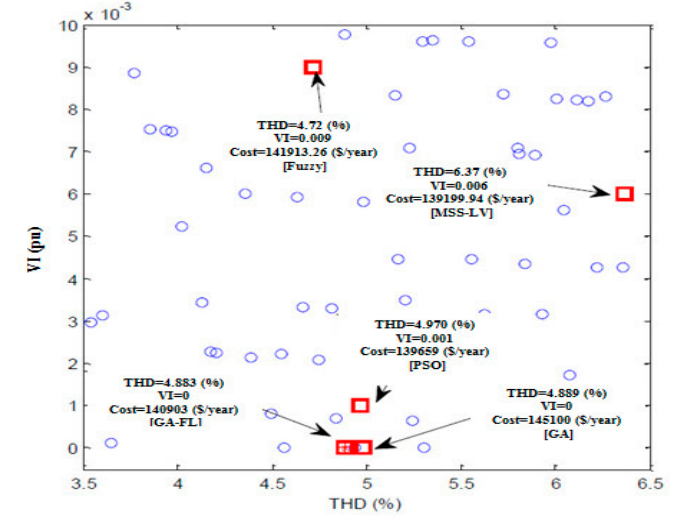
Figure 7. Magnification of the results of the proposed method with the two objectives of THD and VI, along with other methods.